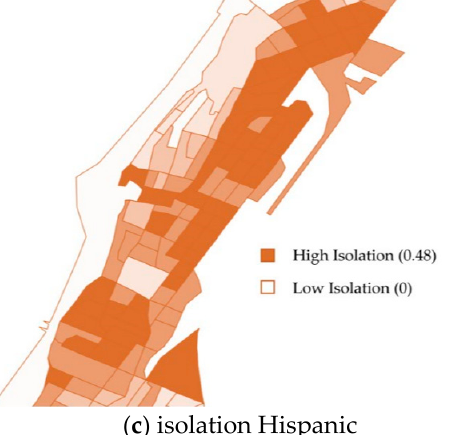
Figure 1. This figure demonstrates the unique information provided by the three different racial residential segregation indices (dissimilarity, interaction, isolation) using the Hispanic group as an example. The maps above show the block groups for Washington Heights and Inwood, New York. ( a ) Dissimilarity index for people who are Hispanic and non-Hispanic White. Darker blue is higher dissimilarity; lighter blue is lower dissimilarity. ( b ) Interaction index for people who are Hispanic and non-Hispanic White. Darker green is higher interaction; lighter green is lower interaction. ( c ) Isolation index for people who are Hispanic. Darker orange is higher isolation; lighter orange is lower isolation. Maps for other 4 indices are provided in Supplementary Figure S3.